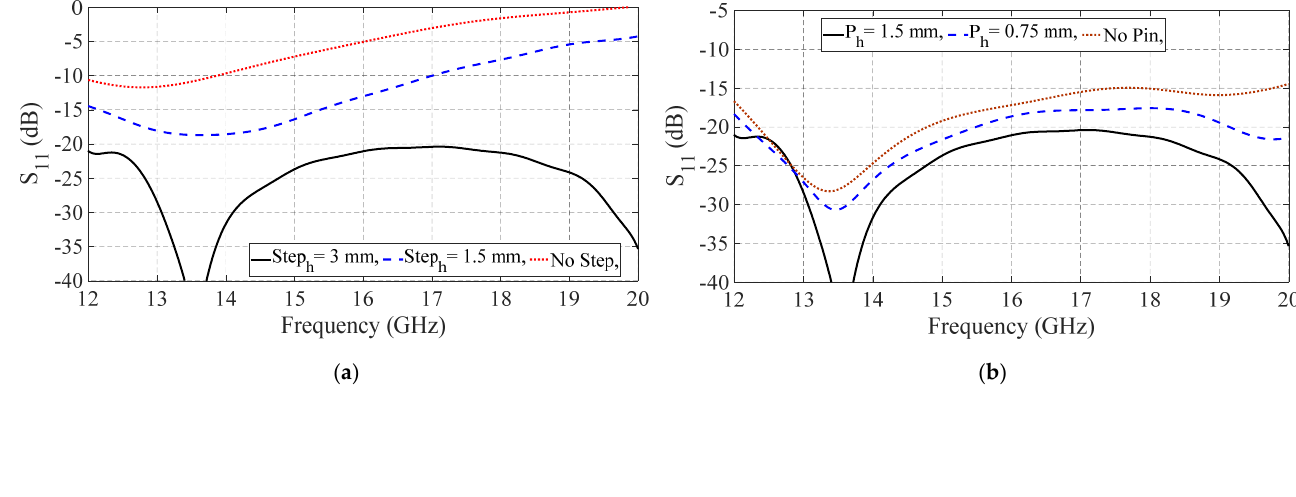
Figure 4. Simulated S-parameters of the transition by sweeping the design parameters: ( a ) step height, ( b ) pin height, and ( c ) window width. 3. Switch Design and Simulation Results The proposed microwave switch is an SP2T based on GGW structure. The geometry of the proposed switch is shown in Figure 5. The input and output ports are located in the top layer. The middle layer, which is the switch sliding part, consists of all gap waveguide pins and matching posts. The switch state can be changed by sliding this layer to the left or right. In addition, two holder parts are introduced to the structure to provide mechanical stability to the sliding part, and they have no effect on the EM functionality of the switch. The switch mechanism works as follows: when the switch is in State A, the pole-port (Port 1) is coupled to the first throw-port (Port 2) using two transitions in a back-to-back arrangement. The EM waves are coupled from Port 1 to the GGW using the first transition, and then they are coupled to Port 2 using the second transition. In this state, Port 3 is shorted using a short-ended cavity in which the side walls are the periodic pins. An inverted copy of the pins and posts is placed beside the first one to form State B as shown in Figure 5c. Due to the gap waveguide concept, the sliding part does not require any connection to the top layer. Consequently, it can slide freely while the wave leakage is totally suppressed by the gap waveguide structure. When the switch is in State B, the pole-port (Port 1) is connected to Port 3, whereas Port 2 is